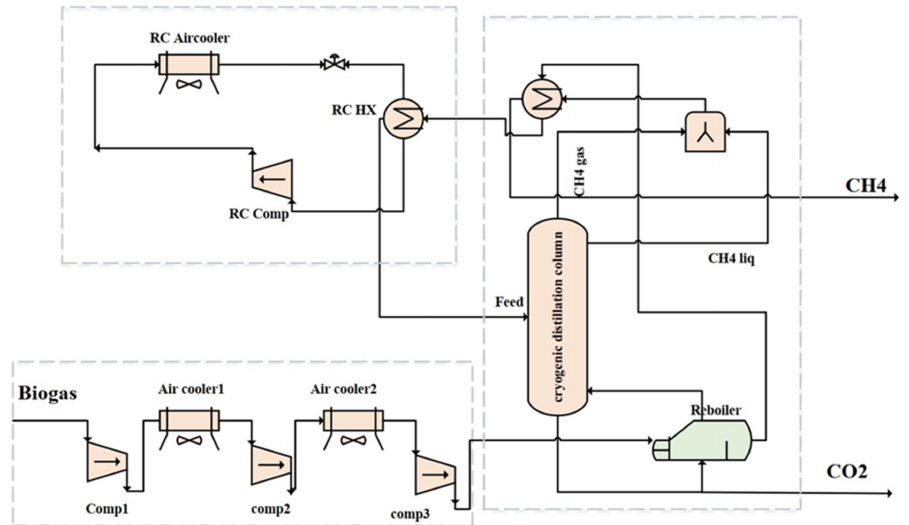
Figure 5. Process flow diagram of cryogenic biogas